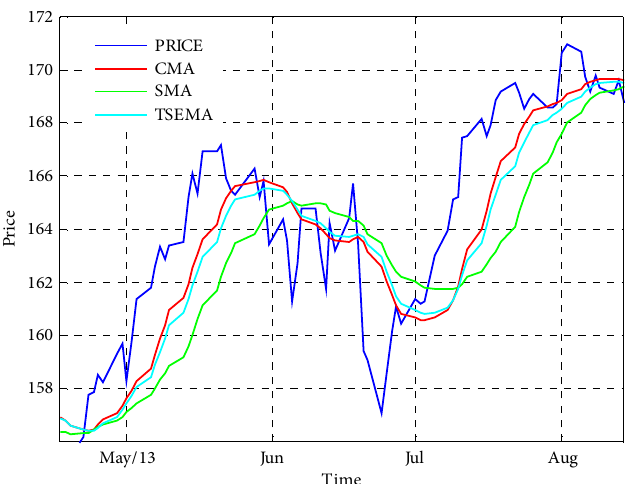
Fig. 10. Smoothed price curve using CMA, SMA and TSEMA. CMA is more accurate than other